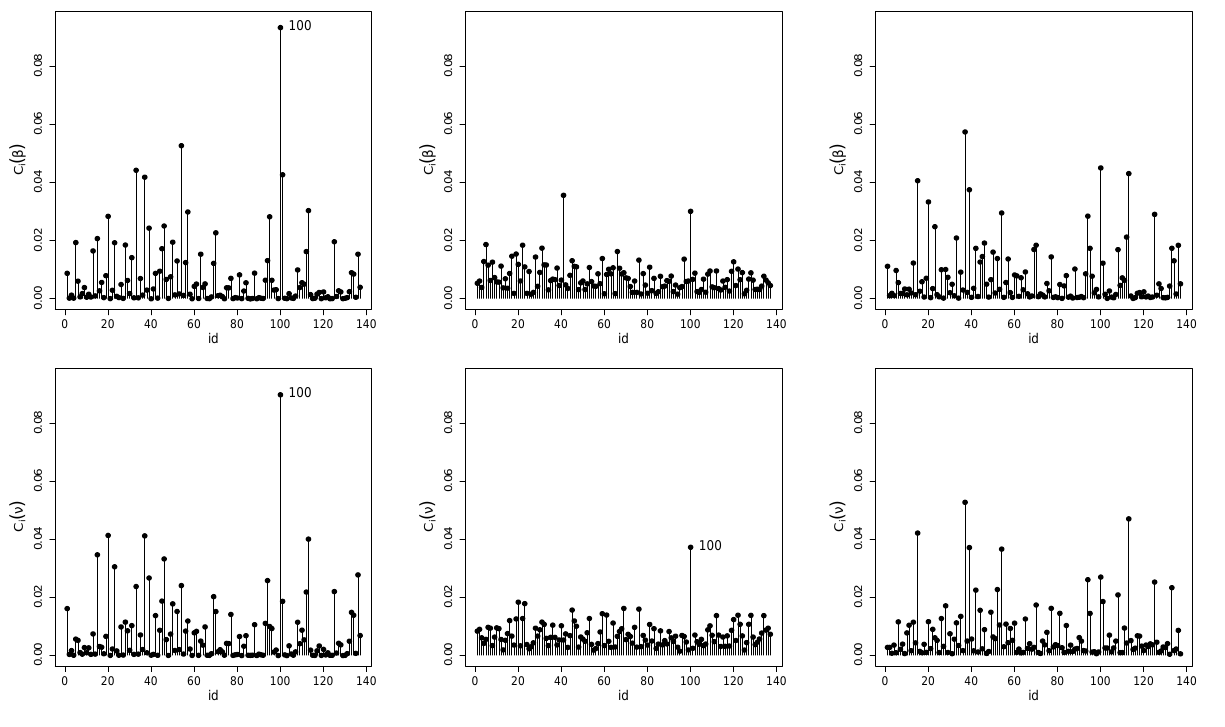
Figure 5. The index plots of C i for (cid:98) β ( upper ) and (cid:98) ν ( lower ) under the weight perturbation ( left ), response perturbation ( center ), and covariate perturbation ( right ) schemes for the RPGJSB2 q = 0.5 model (cloglog link and G the cdf from the logistic model) of the COVID-19 data set. Table 6. The relative changes (in %) in the ML estimates (RC) and their corresponding standard errors (RCSE) for the indicated parameter and respective p -values for the COVID-19 data set, when observation 100 is